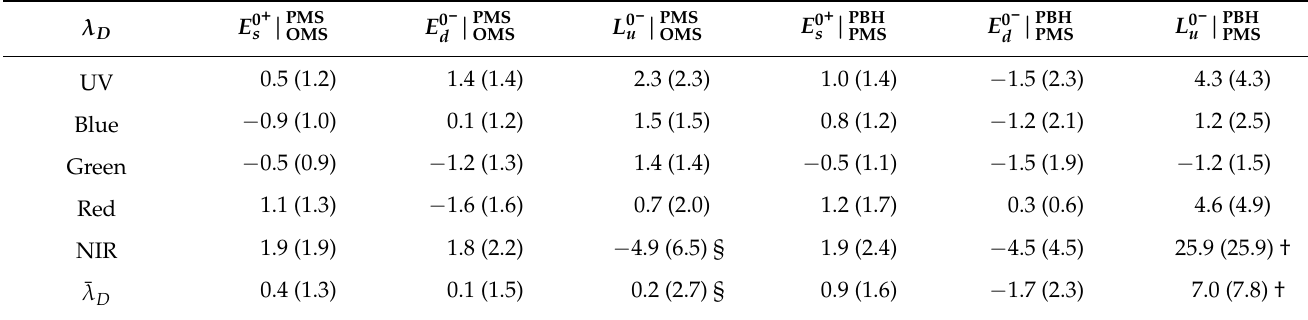
Table 2. The ψ and φ comparison statistics in percent following Table 1 for two detector systems built into a C-PHIRE radiometer based on the lowest-level data products obtained from field observations. PMS C-PHIRE multispectral data are compared to contemporaneous OMS C-OPS data products (left three columns) versus PBH bandpass hyperspectral data compared with the same PMS multispectral data (right three